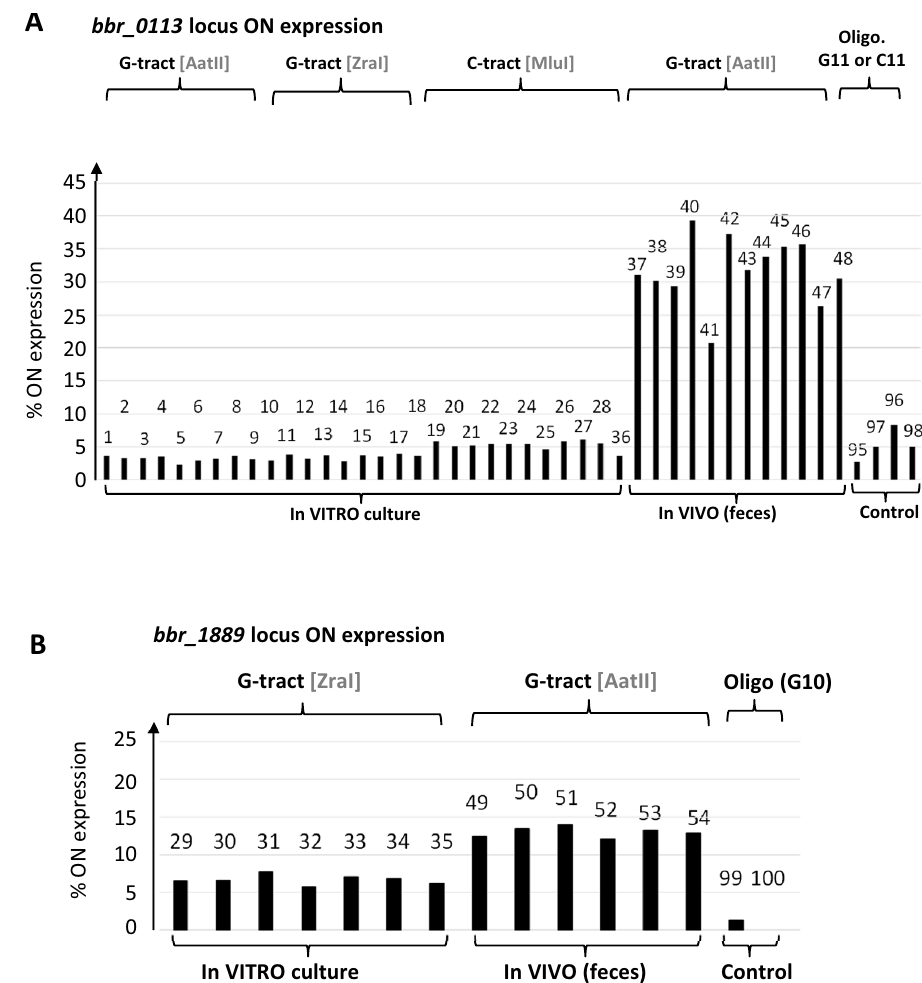
Figure 7. Replication slippage-mediated “ON” expression. The addition of (−1+3n) frequency of indel at G/C tract of bbr_0113 locus ( A ) and bbr_1889 locus ( B ) and multiplied by 100 to yield the percentage of ON expression. The percentage of ON/OFF ratio for bbr_0113 locus (A) and bbr_1889 locus (B) was calculated as follow: (number tracts giving ON expression /total number all tracts) *